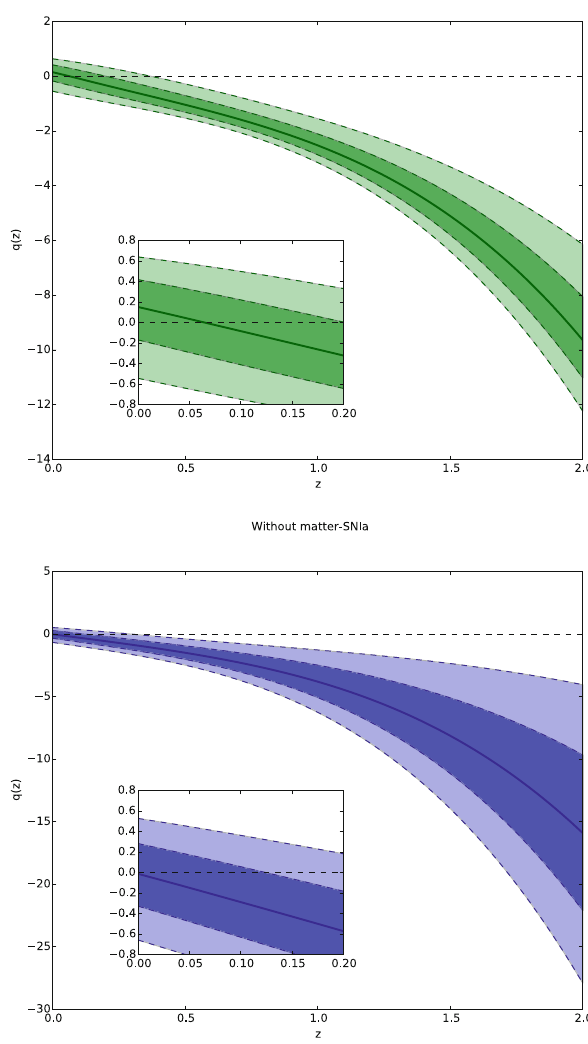
Fig. 13 The top and bottom panels show the reconstruction of the deceleration parameter q ( z ) using the h , h 0 , and b 0 mean values from OHD and SNIa data respectively into the theoretical q ( z ) given by (63). The shadowed areas represent the 1 σ and 2 σ confidence levels. The inset shows the q ( z ) behavior in the range 0 < z < 0 .